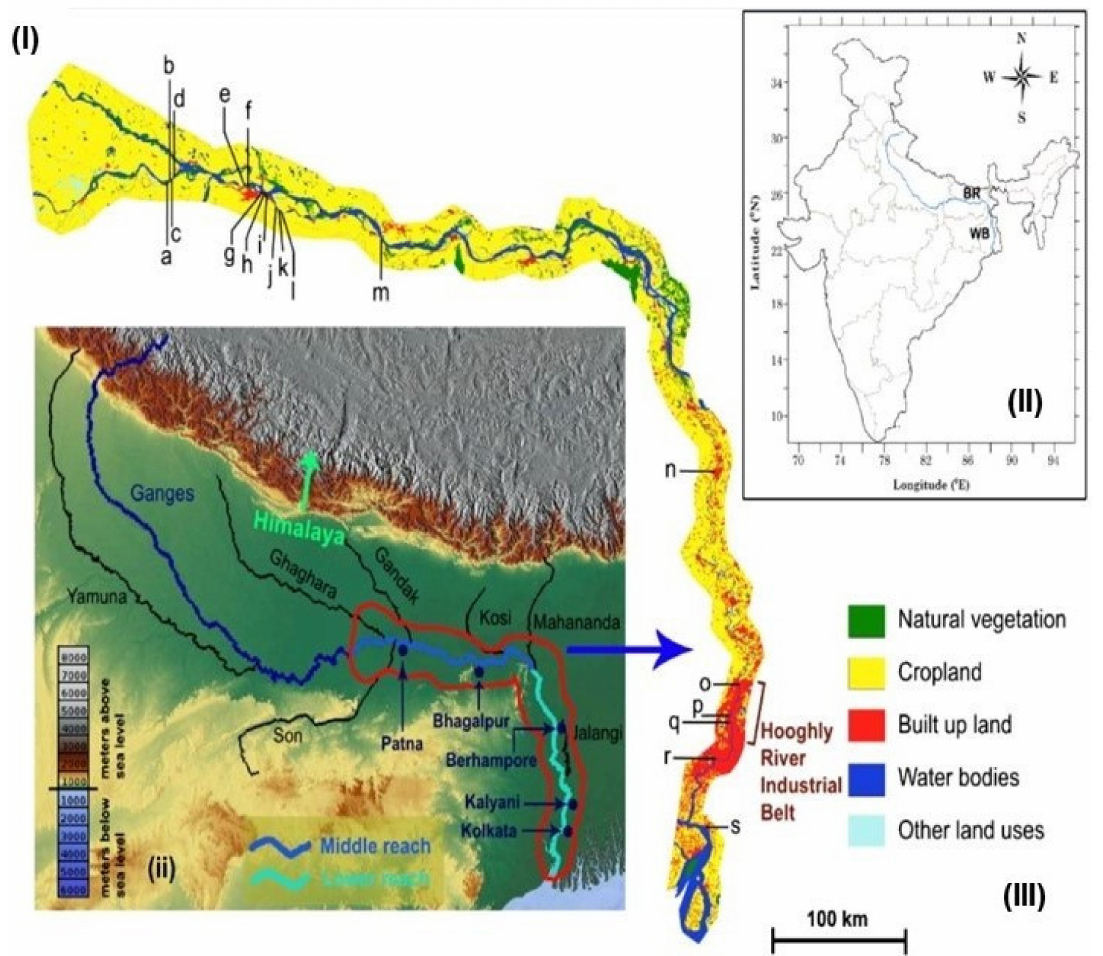
Figure 1. Map of the study area, displaying ( I ) Ganges river basin in India and the two Indian states within the study area, Bihar (BR) and West Bengal (WB); map of the Ganges river (blue line) and its major tributaries (black line) ( ii ); in foreground, the topography of parts of northern and eastern India ( II ). The study sites in the middle and lower reaches of the Ganges are marked in the map. Major cities/towns within the study are also marked; ( III ) land use and land cover map are shown (data for 2005 at 100 m resolution are collected from the Oak Ridge National Laboratory archive [16]. The water quality monitoring locations along the Ganges river are marked as: a: Chausa Buxar; b: Jail Ghat Buxar; c: Ramrekha Ghat Buxar; d: Buxar Bridge; e: Danapur Pipapul; f: Kurji Dargah; g: NIT Patna; h: Gulbi Ghat; i: Gai Ghat; j: Kachchi Dargah; k: Triveni Ghat Fathua; l: Kewala Ghat; m: Begusarai Simaria Ghat; n: Berhampore; o: Kalyani; p: Palta; q: Sreerampore; r: Garden Reach; s: Diamond